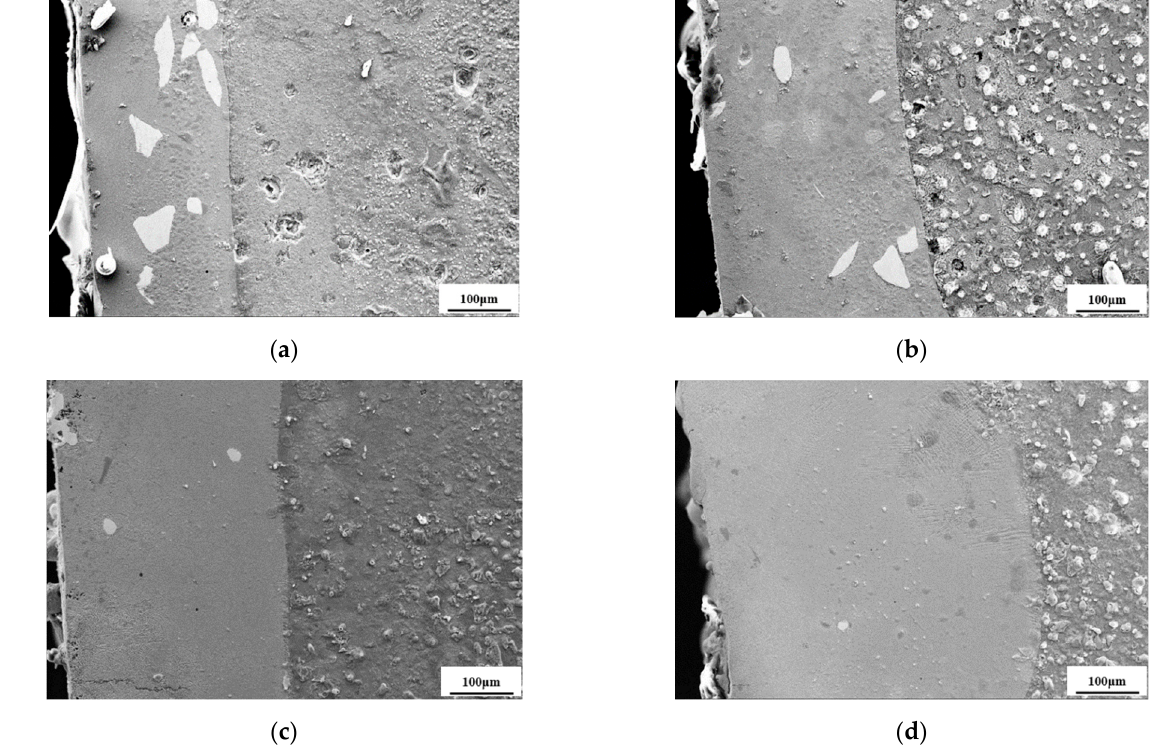
Figure 4. Cross-section morphology of the laser cladding sample: ( a ) section morphology of the 1200 W cladding layer and substrate; ( b ) section morphology of the 1400 W cladding layer and substrate; ( c ) section morphology of the 1600 W cladding layer and substrate; ( d ) section morphology of the 1800 W cladding layer and substrate.